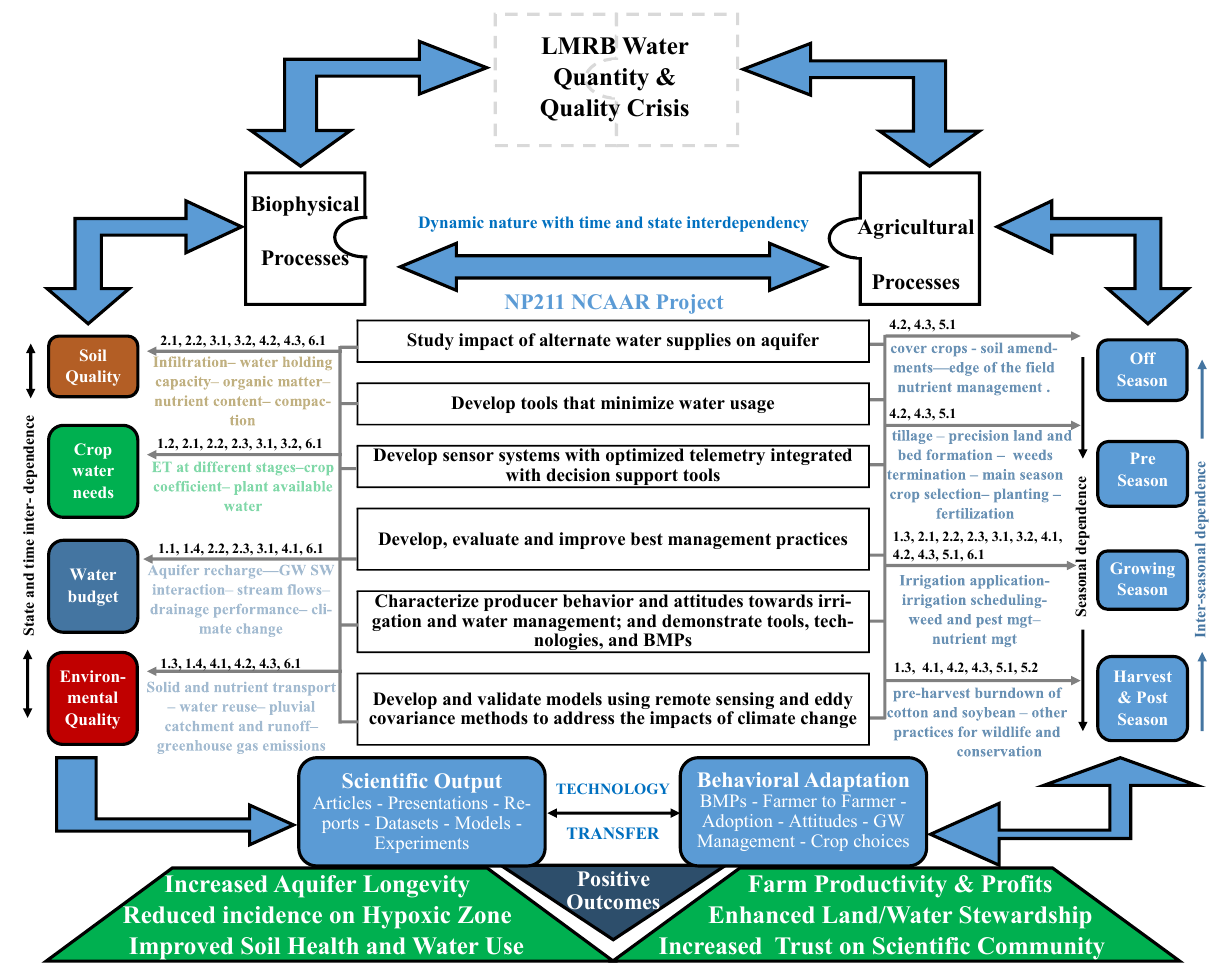
Figure 1. Conceptual diagram of USDA ARS NP211 that funds the National Center for Alluvial Aquifer Research (NCAAR). The Mississippi River Valley Alluvial Aquifer (MRVAA, see Figure 2) is the primary source of water for irrigation for the Lower Mississippi River Basin (LMRB) and is depleting at an unsustainable rate [1,2]. The increase in global population, the resulting growing demand for food, and the receding irrigated acreage in areas where aquifers are depleting require ever increasing levels of productivity from agricultural areas that are relatively rich in water resources, such as the LMRB [3,4]. NCAAR’s mission leverages multidisciplinary agricultural research to alleviate and ultimately contribute to solving the problem of a depleting MRVAA. Aligned with this mission is research at the experimental plot or field level that reduces crop water use without a significant impact on baseline yields, increases crop productivity for a baseline level of water use, or increases the capture of available water by allowing earlier planting to capture natural precipitation or developing infrastructure to capture irrigation or pluvial runoff for reuse. Plot and field-level research in this area show growing evidence that important water savings are achievable with relatively minor modifications to existing irrigation and agronomic practices in the Mid- South USA [2,3,5–10]. However, regional or basin-wide implications of the potential results of wide producer adoption of these practices have not been